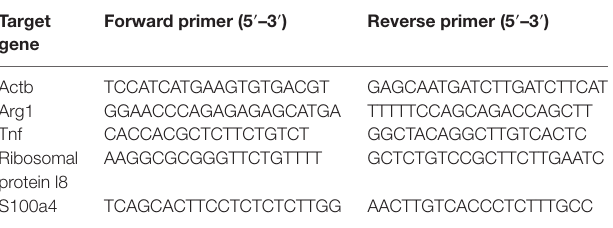
TaBle 1 | Primer sequences of genes of interest (GOI). Target gene